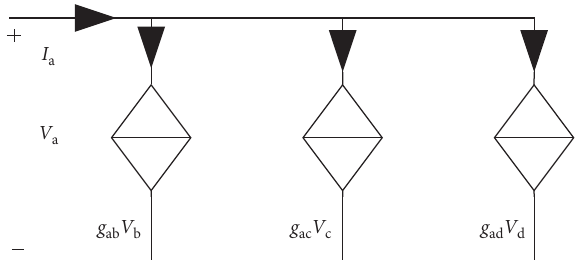
Figure 7: DC conversion average